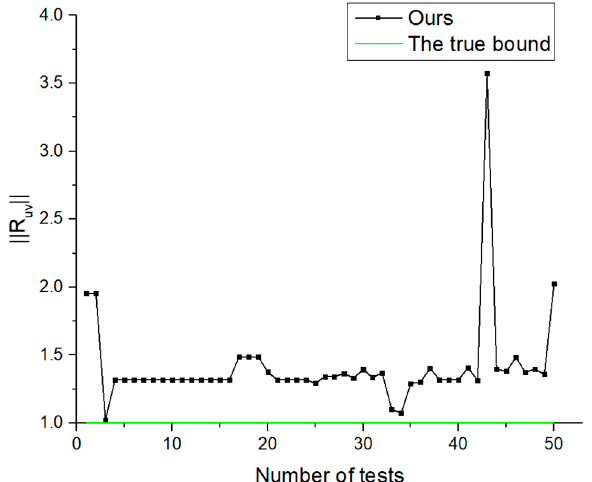
( ) R u of NURBS surfaces ( ) uv R u of NURBS surfaces uv